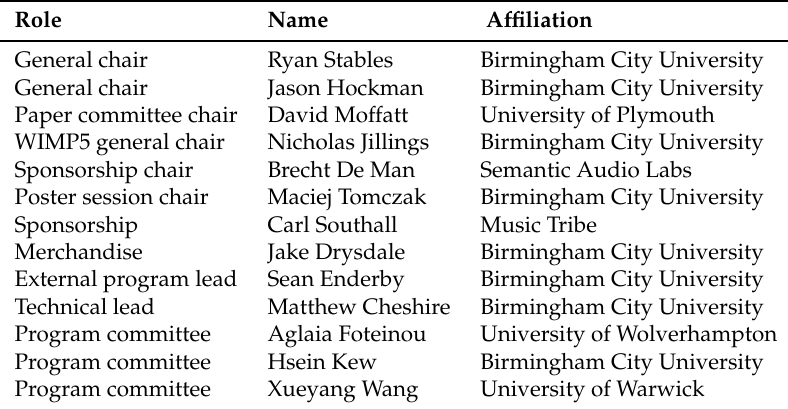
Table 1. The DAFx 2019 Organizing